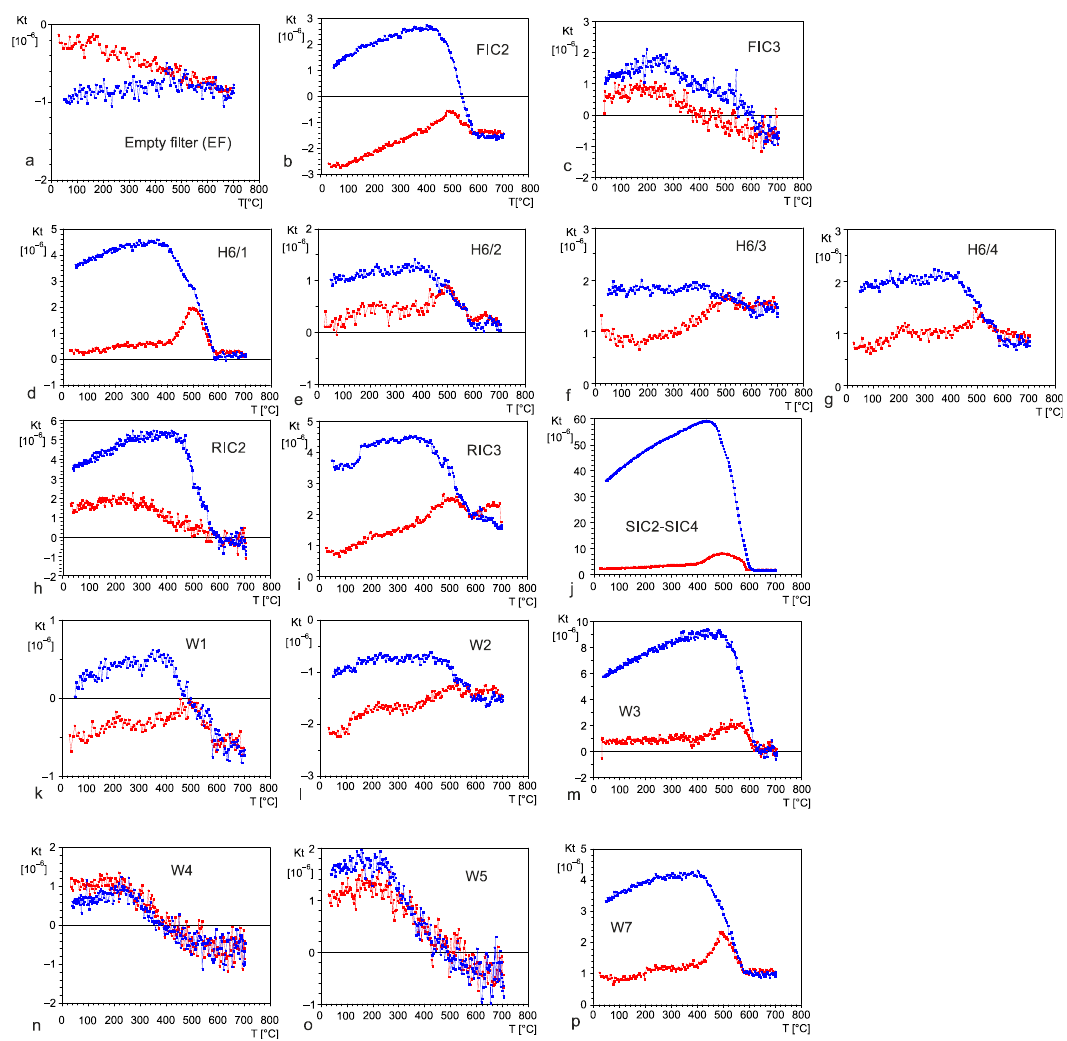
Figure 10. Changes in magnetic susceptibility during heating–cooling cycles (20–700 °C). Red—heating curves; blue—cooling curves. ( a ) Curve for an empty fresh filter; ( b – p ) curves for dust residues, with the signal from the empty filter subtracted. Data from a KLY5/CS4 device (Agico, Brno, Czech Republic).